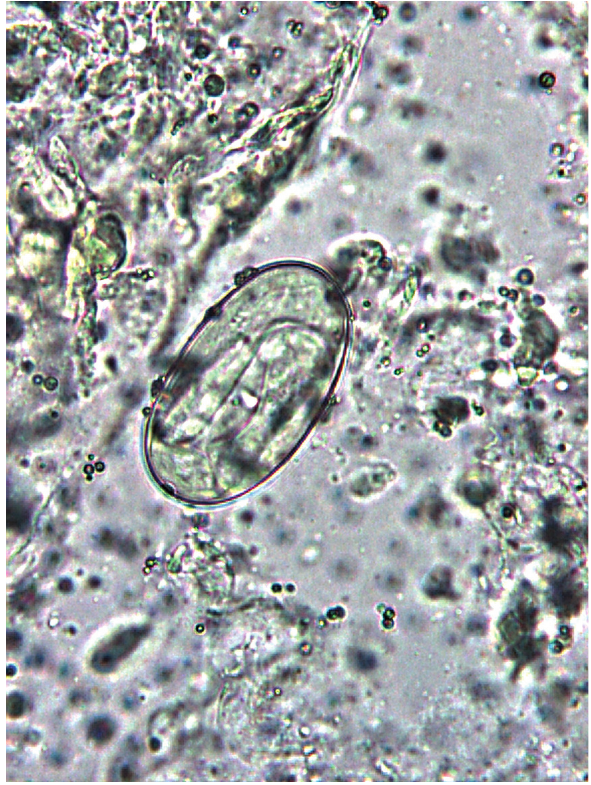
Fig. 1. – Embryonated egg of Serratospiculum seurati , 50 x 25 µm ( × 400).